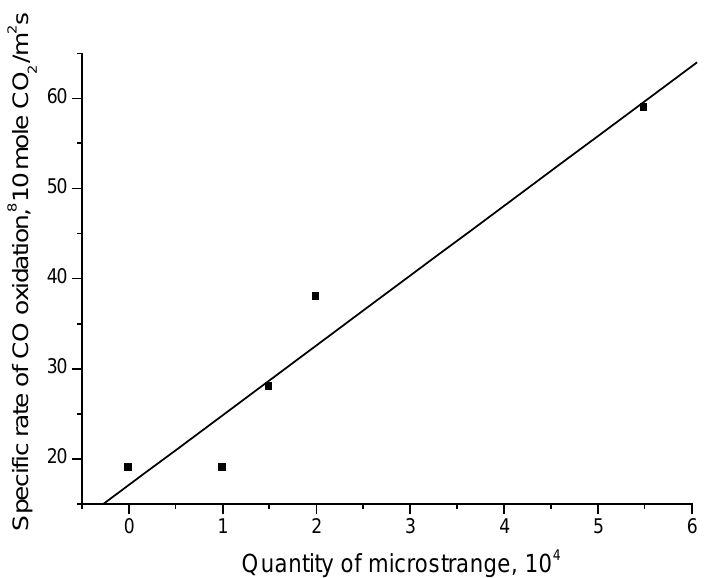
Fig.2 Dependence of the specific rate CO oxidation on the quantity of microstrange.